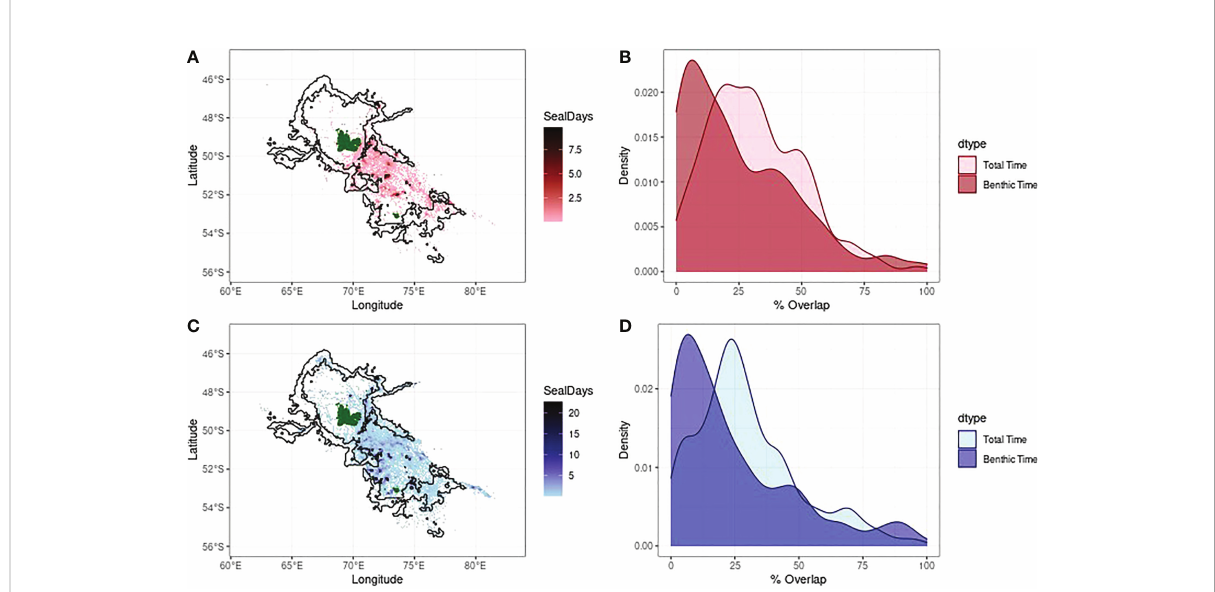
FIGURE 6 Degree of overlap between female and male elephant seals and commercial fi shing on the Kerguelen Plateau. (A) Females: the number of seal days spent on benthic diving on the Kerguelen Plateau. Black contours indicate the commercial fi shing grounds described in Peron et al., 2016). (B) Females: The frequency distribution (expressed as a kernel density) of the percentage of total time that individual seals spent in the commercial fi shing grounds (% overlap), presented for both the total time diving and for benthic dives alone. (C, D) show the same information for males.